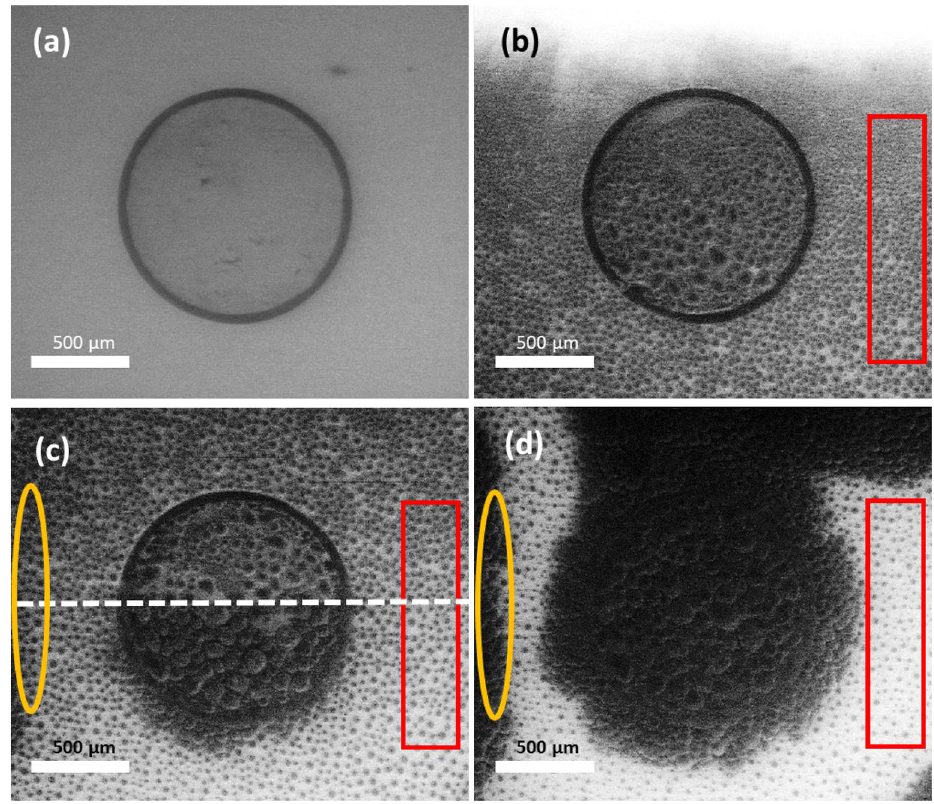
Figure 7. Time-resolved ESEM of the condensation of water vapor, caused by a pressure excursion, on a myoglobin spot on copper. ( a ) t = 0 s and P = 126 Pa. No ice or SCW are detected. ( b ) t = 3 s and P = 135 Pa. SCW starts to appear on the protein spot and on the copper substrate. The red rectangle indicates a detail of SCW on the bare copper surface, and the yellow ellipse marks a copper zone free of SCW. ( c ) t = 6 s and P = 128 Pa. During the scan, SCW evaporates in the red zone. At the same time, ice growth is triggered inside the protein spot (see the dotted white line) and causes crystallization of neighboring SCW droplets by ice bridging. ( d ) t = 9 s and P = 129 Pa. Ice now covers the complete protein spot. It has also appeared in the yellow area, which is not in contact with the spot. SCW continues evaporating in the red zone. Modified with Power Point (www. micro soft. com/ es- es/ micro soft- 365/ power